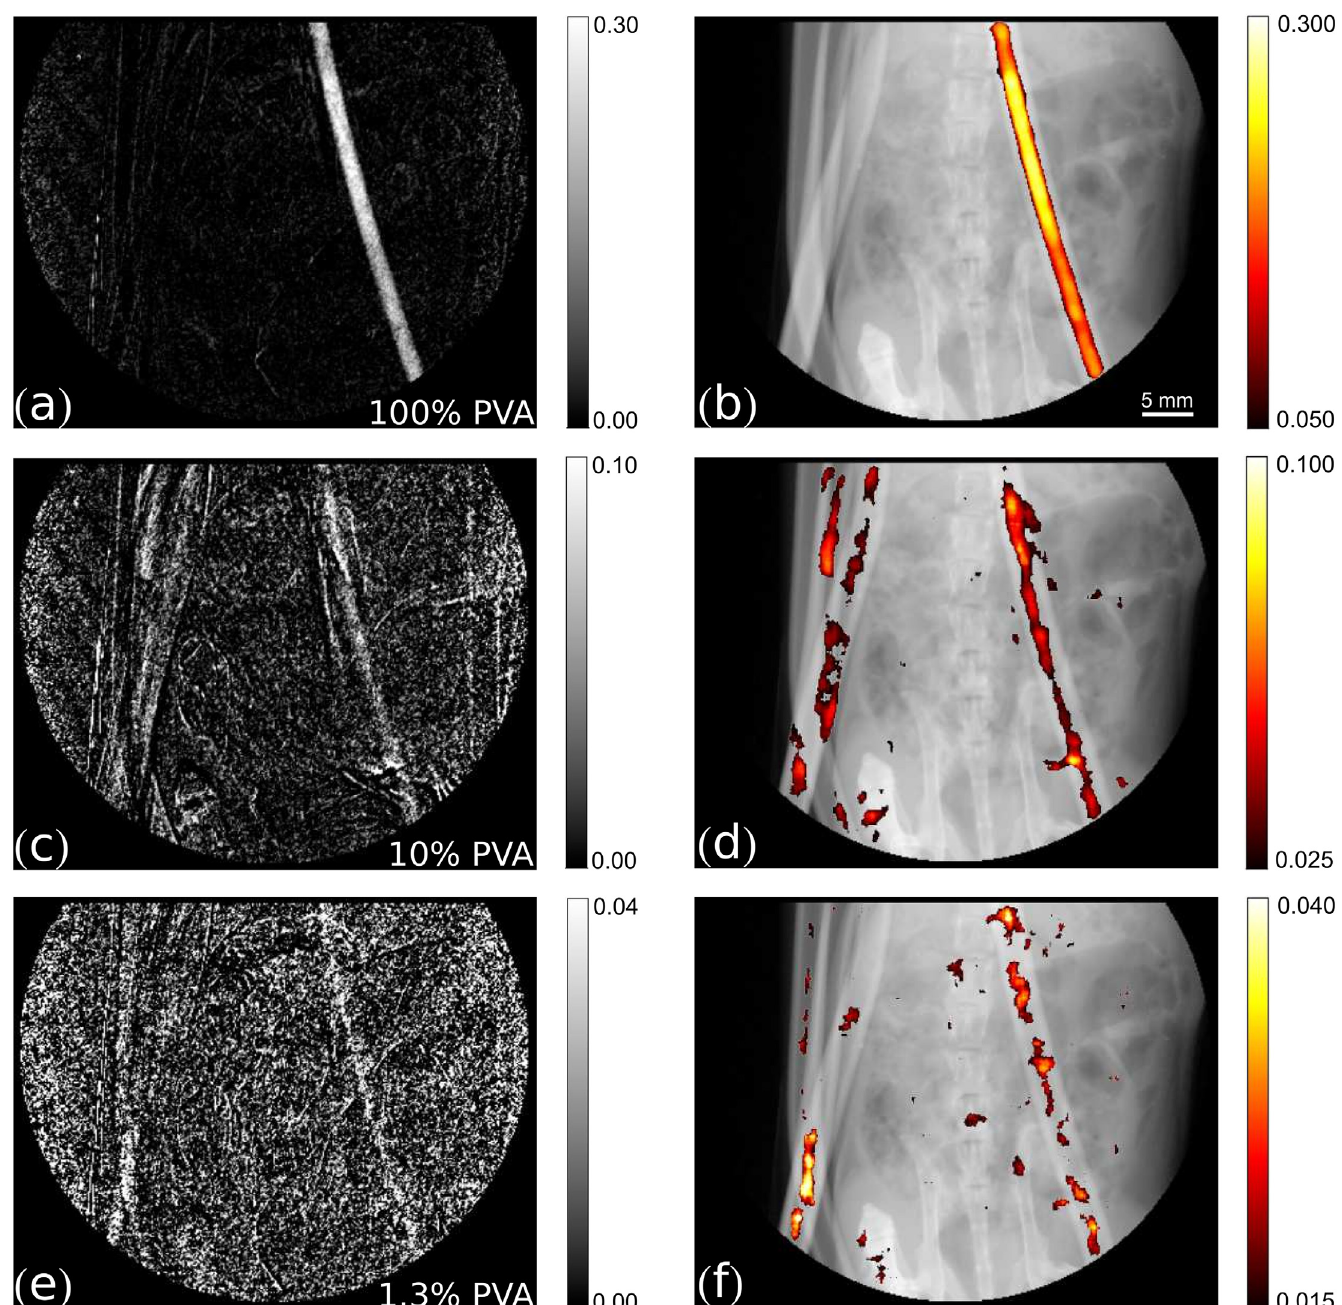
Fig 4. Dark-field signal subtraction and multimodal images. Left column: dark-field signal subtraction images. Right column: threshold-limited, filtered superimposition of the dark-field subtraction image (in color) on the respective original transmission image (grey values range: [0, 0.9]). (a)-(b) 100% PVA microbubbles suspension, (c)-(d) 10% PVA microbubbles suspension, (e)-(f) 1.3% PVA microbubbles suspension.